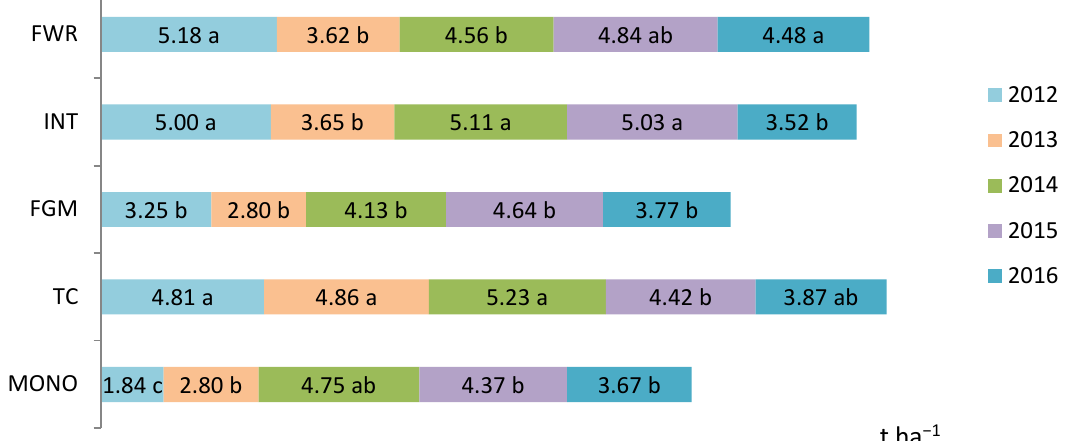
Figure 5. Winter rye grain yield in different crop rotations, 2012–2016. Note: different letters indicate significant differences between the treatments ( p ≤ 0.05); FWR—field rotation with row crops; INT—intensive rotation; FGM—rotation for green manure; TC—three-course rotation; MONO—rye monoculture.